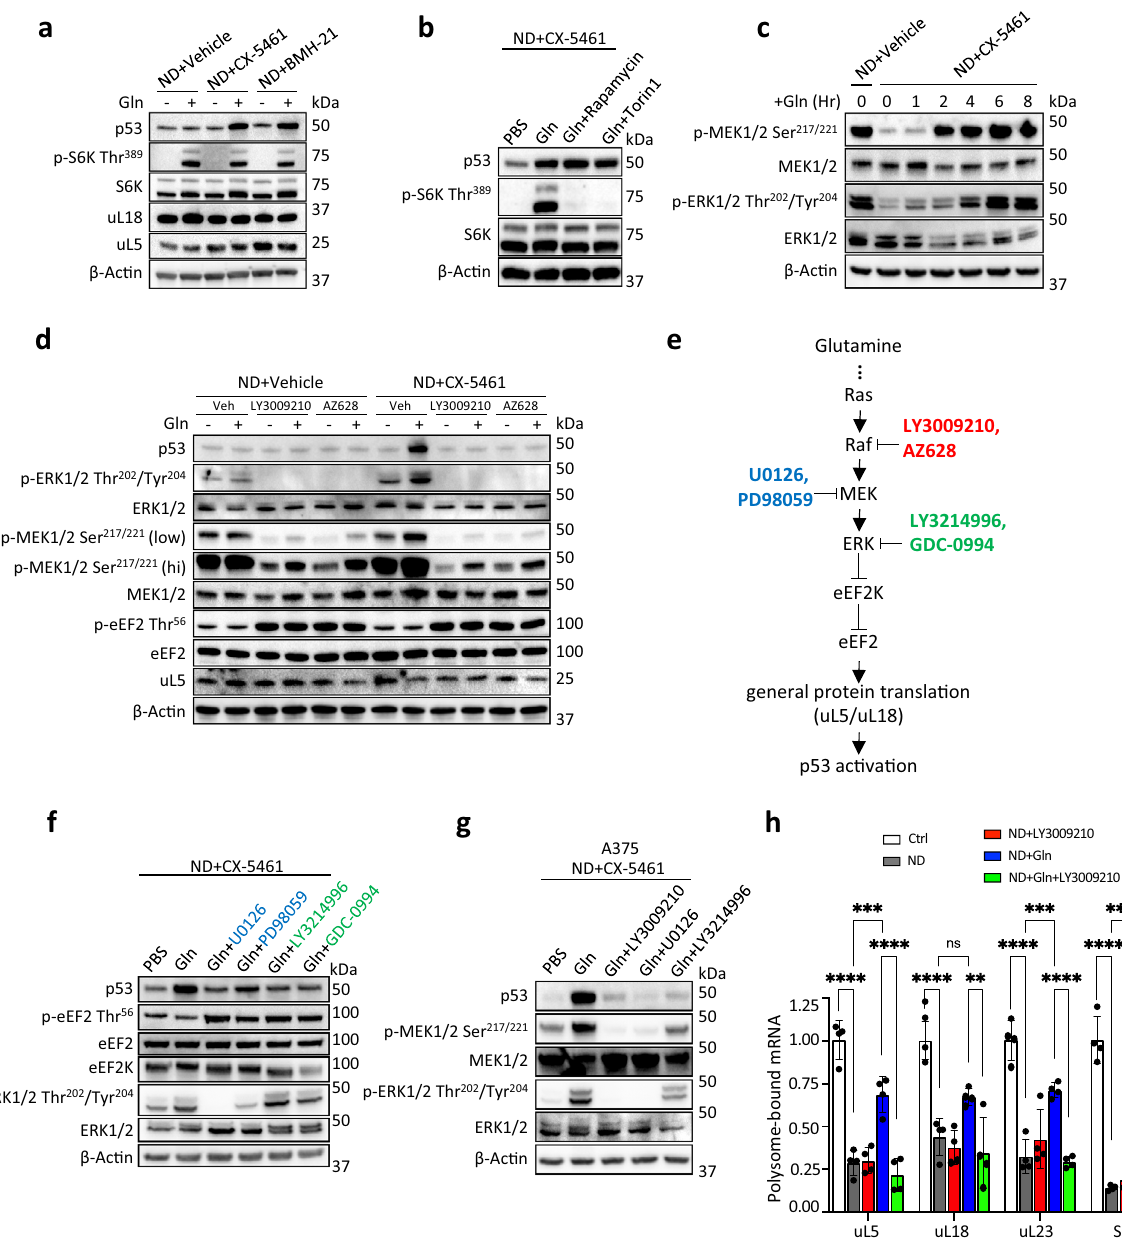
Fig. 5 Glutamine metabolically activates p53 by inducing uL5/uL18 translation. a Glutamine (gln) activates p53 in pre-rRNA depleted HCT116 cells as assessed by western blotting. HCT116 were cultured in ND medium with vehicle (NaH 2 PO 4 ), CX-5461 (10 µ M), or BMH-21 (1 µ M) for 24 h. After 24 h the old treatment media was replaced with ND media containing PBS or Gln (4 mM) for 8 h. b Inhibiting mTORC1 with Rapamycin (1 µ M) or Torin1 (1 µ M)